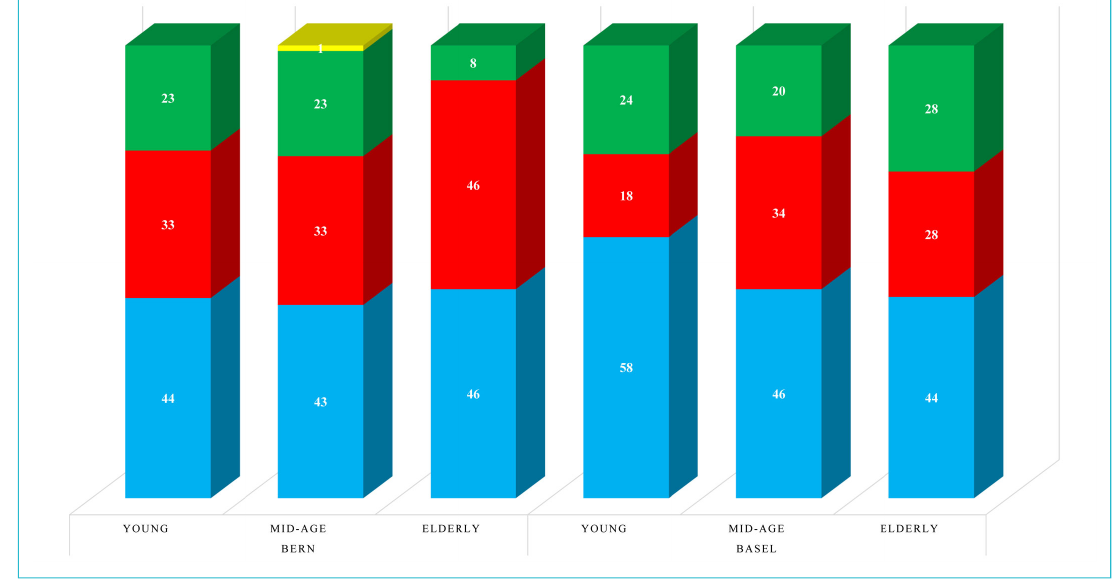
Table 2: Reported co-use patterns in Bern and Basel by severity of intoxication.